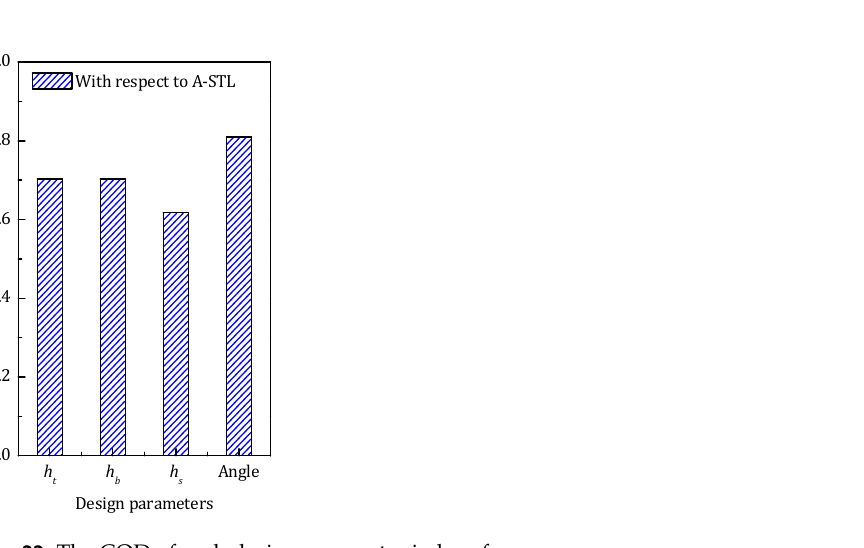
Figure 22. The COD of each design parameter in low-frequency range. Table 4. Results after optimization in the middle-frequency range.